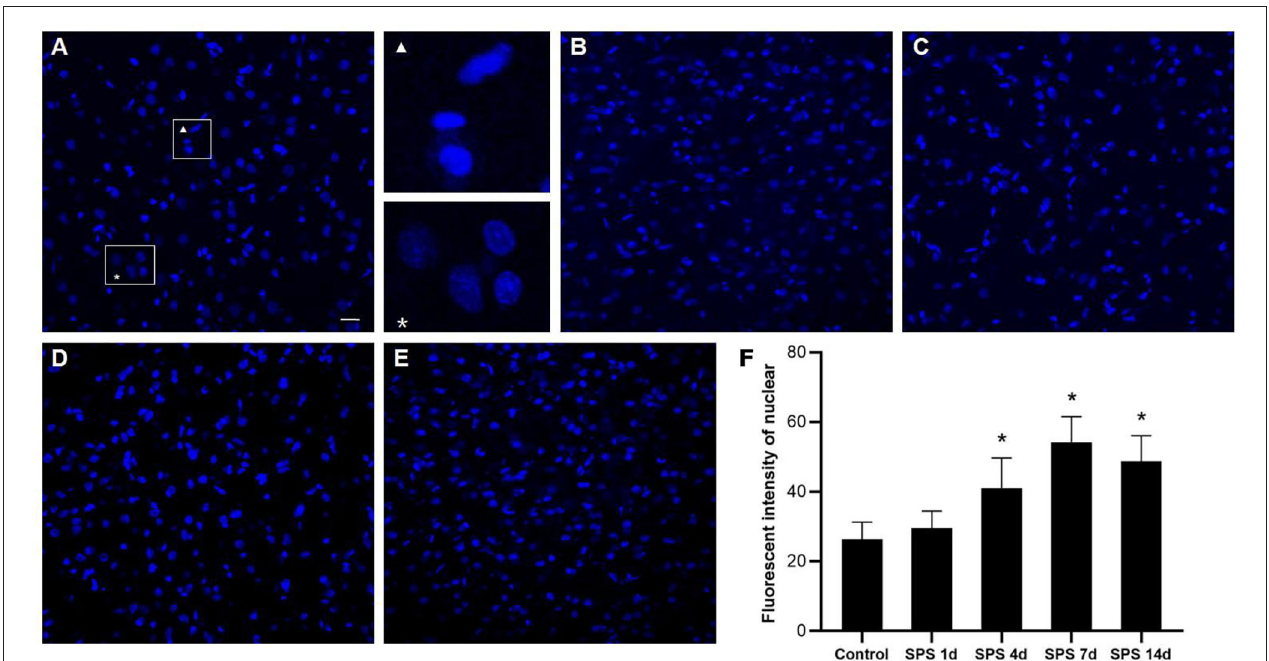
Frontiers in Psychiatry |